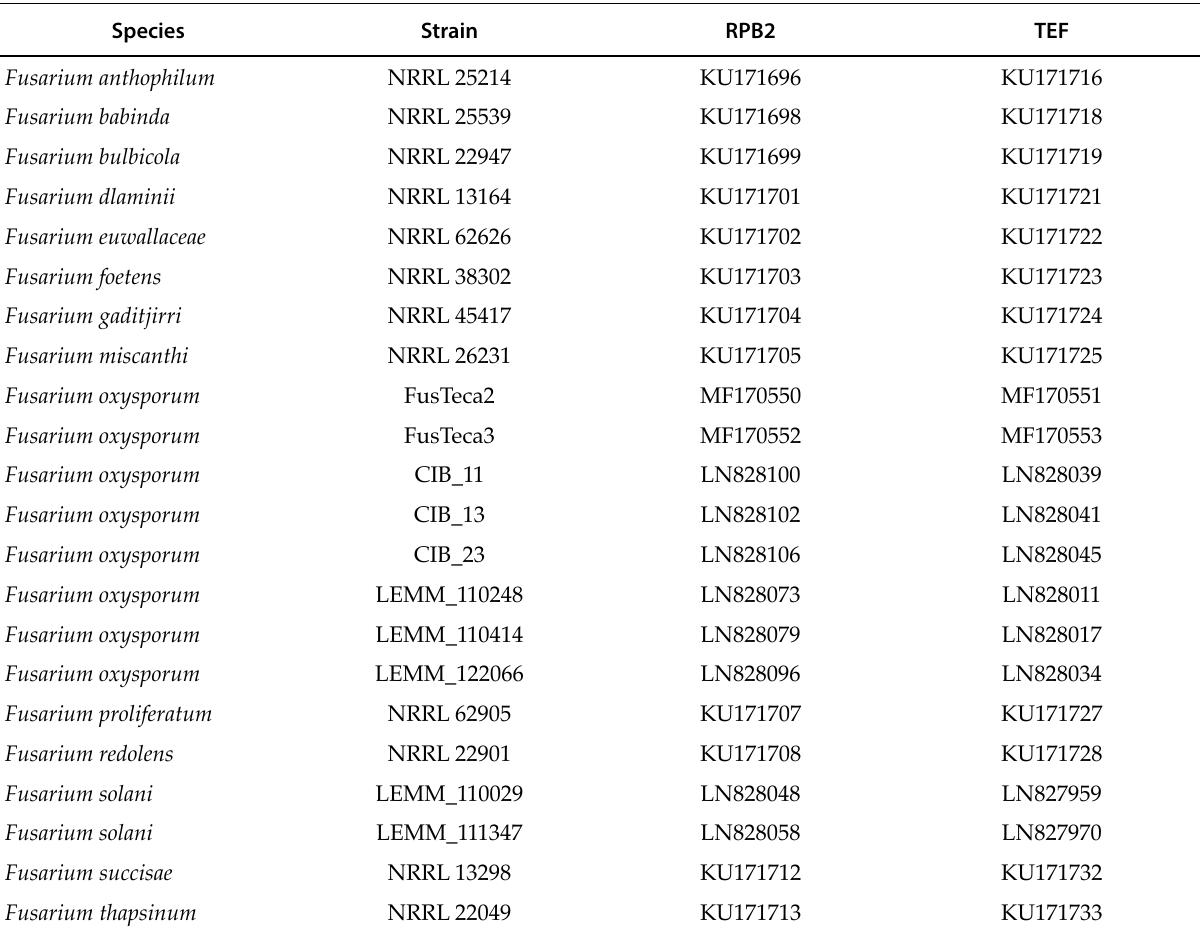
Table 1. Species